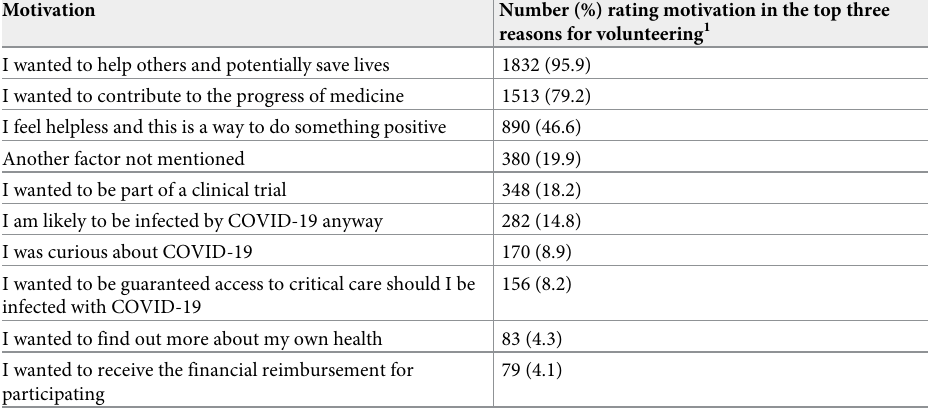
Table 2. Volunteer group motivations for participating in human challenge studies.